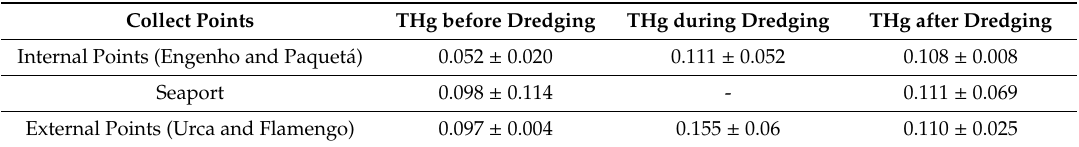
Table 2. Mean values and standard deviation of THg (mg kg − 1 ) w.w. in swimming crabs, collected in the internal, Porto and external points of Guanabara bay, before, during and after